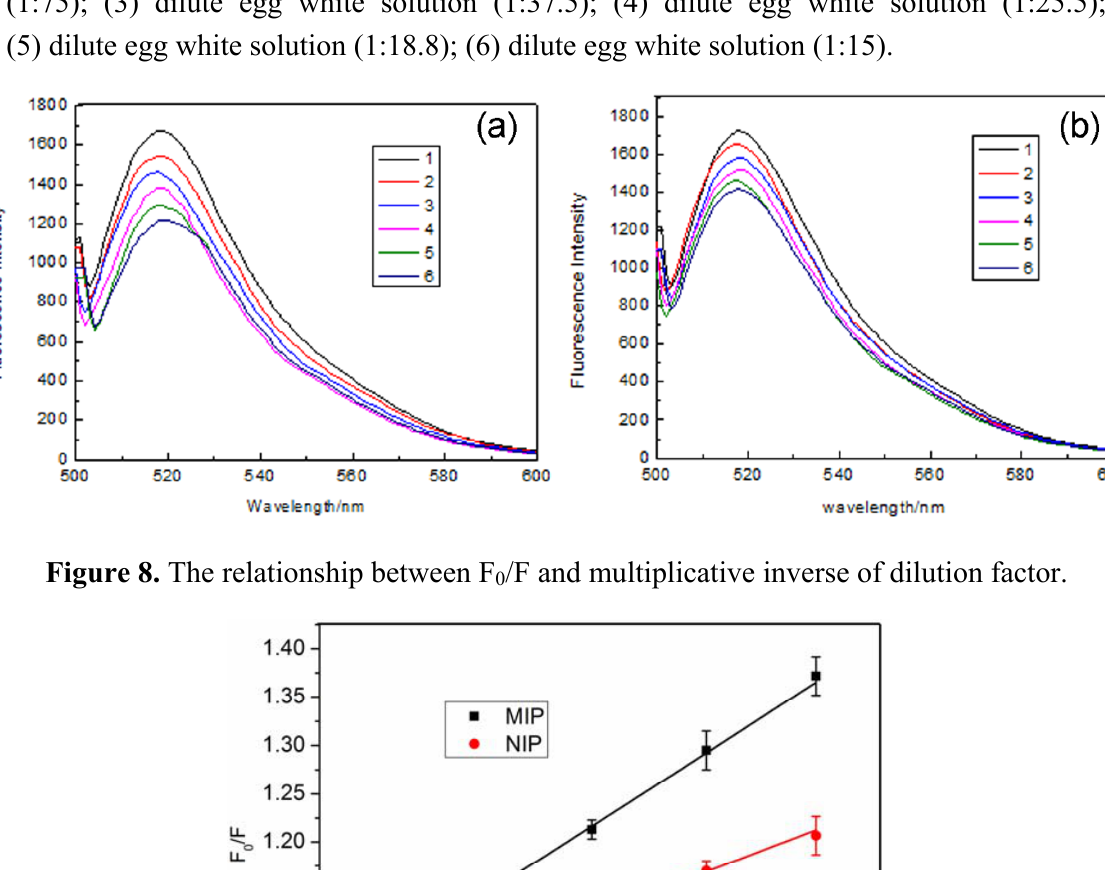
Figure 7. Fluorescence spectra of MIP ( a ) and NIP ( b ) with increasing Lys concentration in egg white. (1) Without addition of egg white solution; (2) dilute egg white solution (1:75); (3) dilute egg white solution (1:37.5); (4) dilute egg white solution (1:25.5);